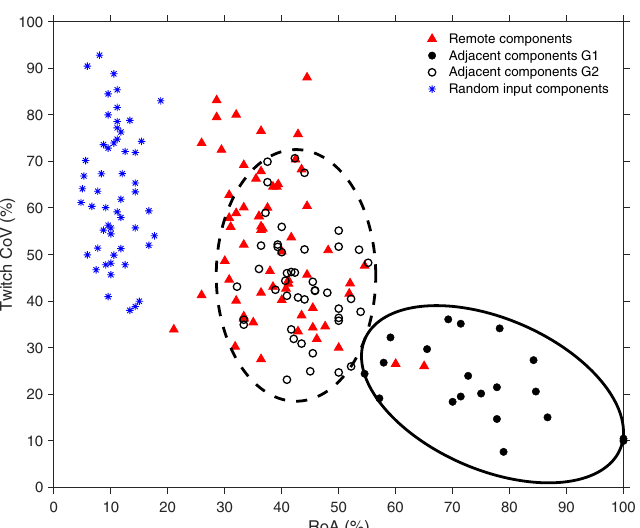
Figure 2. Successful identification of MUs were based on RoA (the rate of agreement between component and MU firing patterns) and twitch CoV (twitch variability with respect to MU firings). Remote components (triangles), adjacent components (circles), and random input components (asterix) are visualized. The adjacent components (circles) are divided into two groups, i.e., adjacent components G1 (filled circles) and adjacent components G2 (unfilled circles) by using K-means method. The two groups are illustrated using ellipses. Asterix (blue) corresponds to components from random noise input to the decomposition